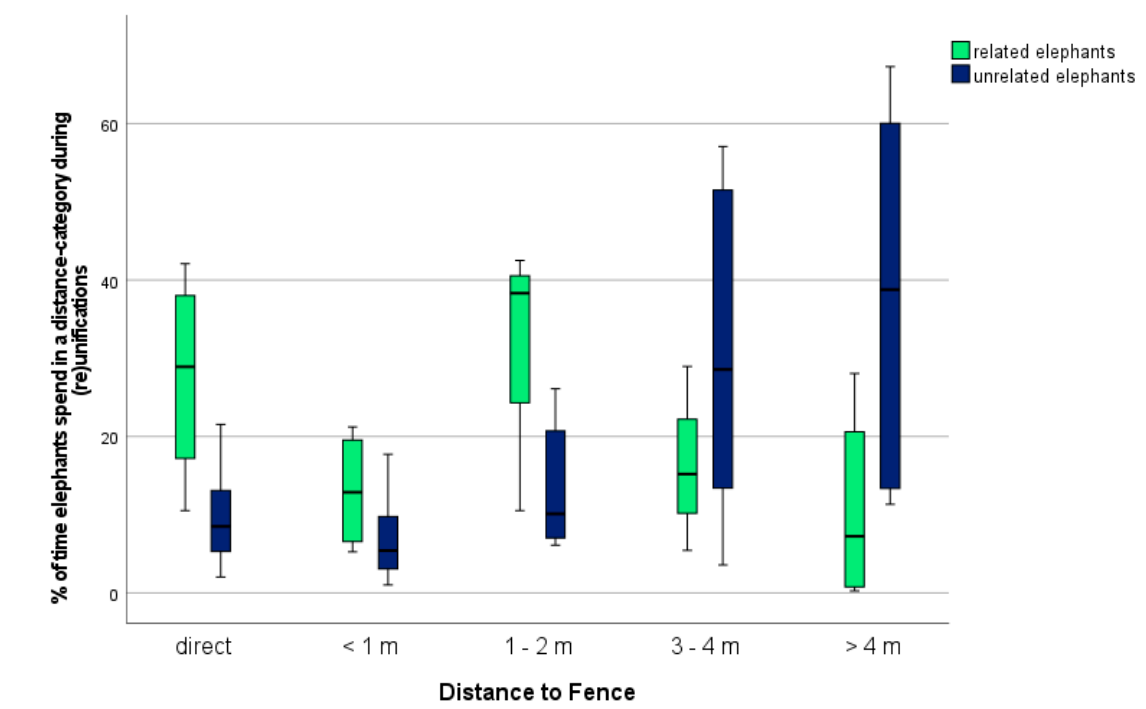
Figure 2. Percentage of time that related and unrelated elephants stood at a certain distance to the fence during (re)unification.